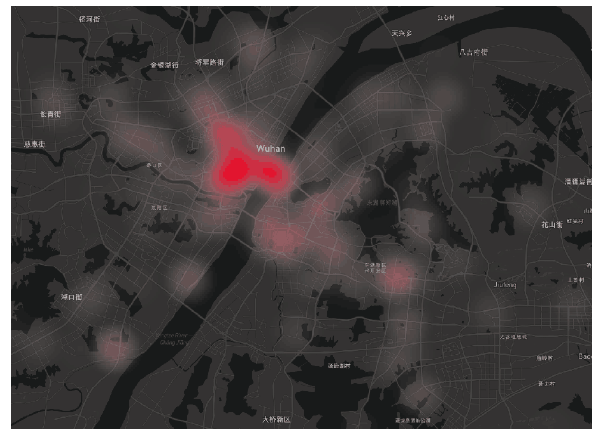
Figure 3. Thermogram of possible waterlog zone in 2017